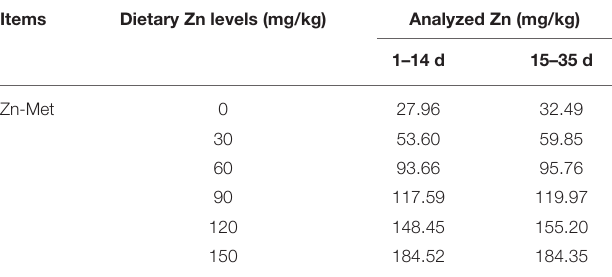
TABLE 2 | Analyzed Zn concentration of diets (air-dry